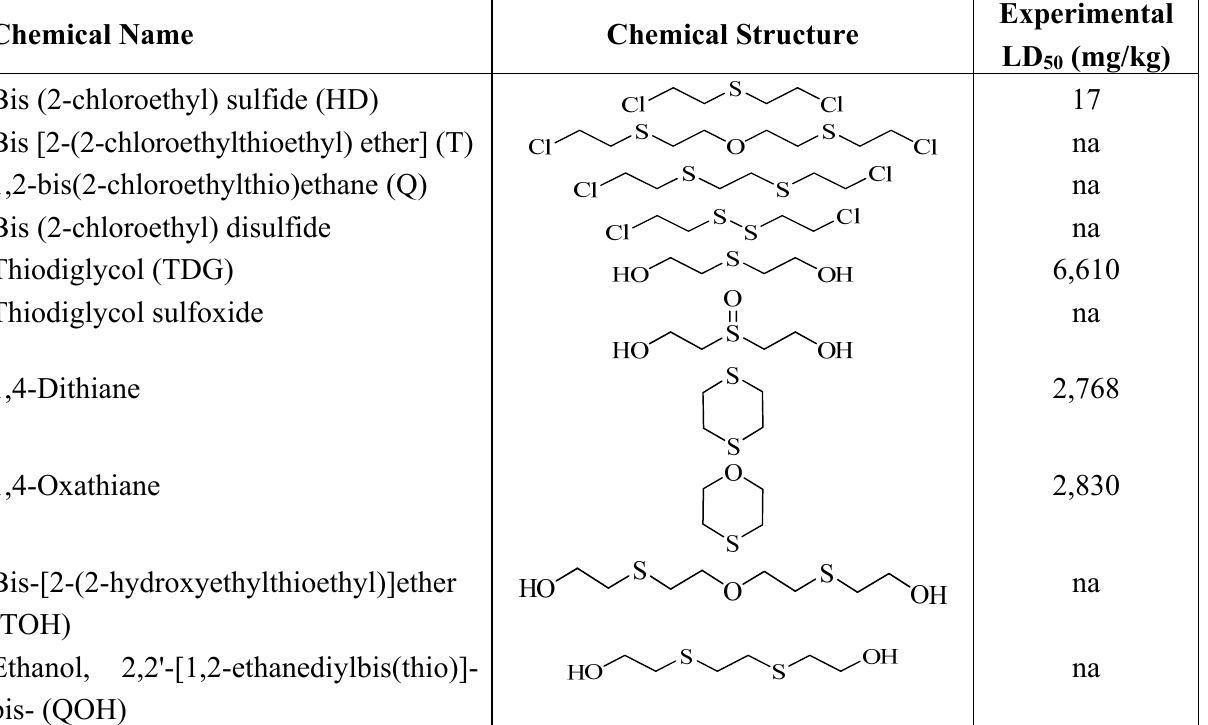
of HD and its breakdown 50